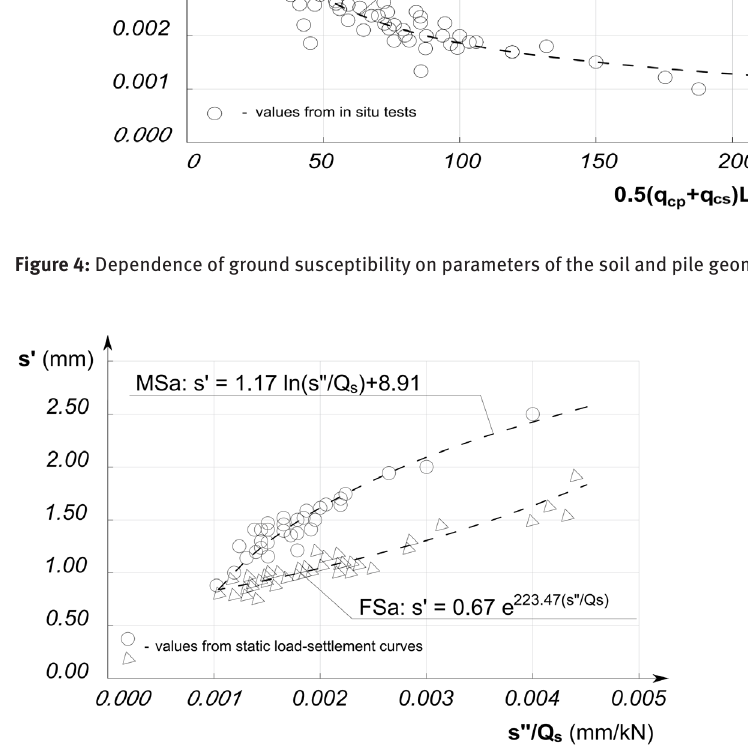
Figure 5: Dependence of the initial point of the exponential function s’ on ground